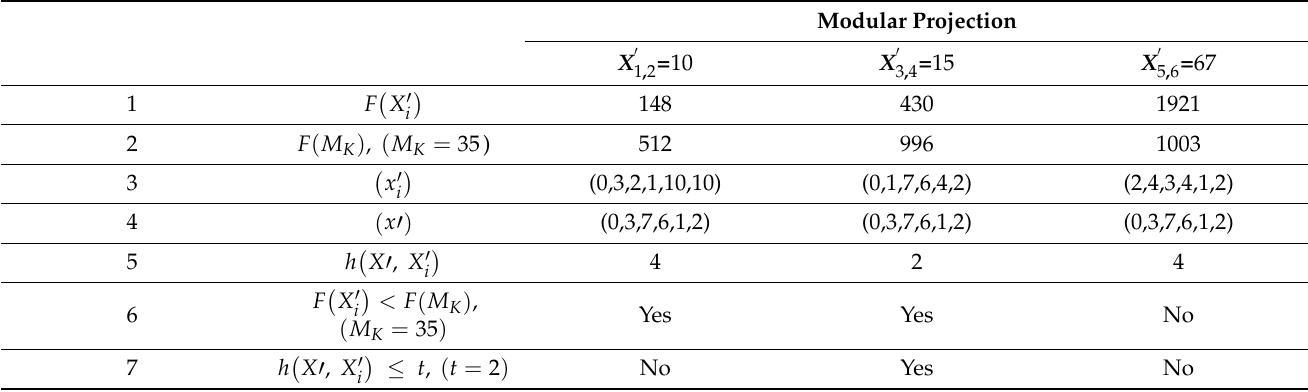
Table A6. Computed modular projections and their characteristics.